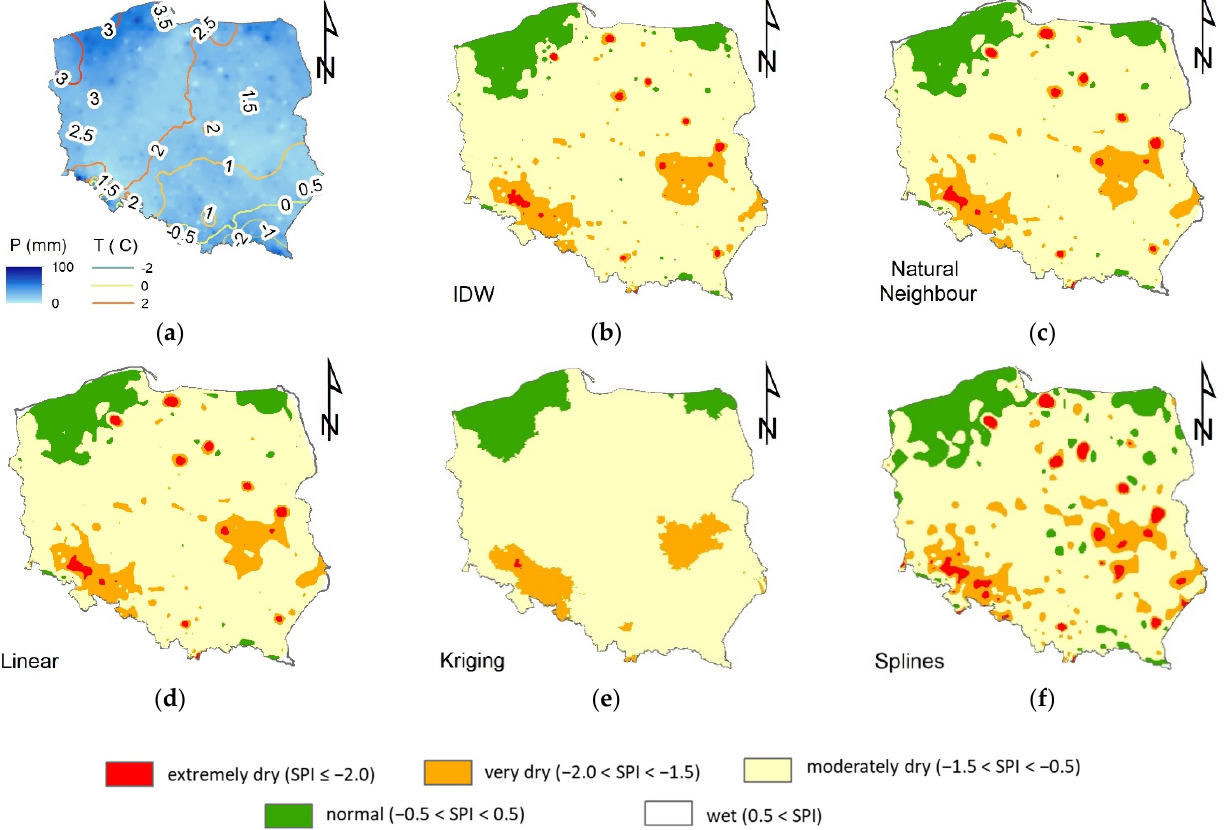
Figure 5. Interpolated monthly results for the beginning of the period of study, January 1990. Part ( a ) presents monthly sums of precipitation and isolines of mean temperatures. The other parts show interpolation of SPI-1 with different methods ( b ) Inverse Distance Weighted, ( c ) Natural Neighbor, ( d ) Linear algorithm, ( e ) Kriging, ( f ) Splines.